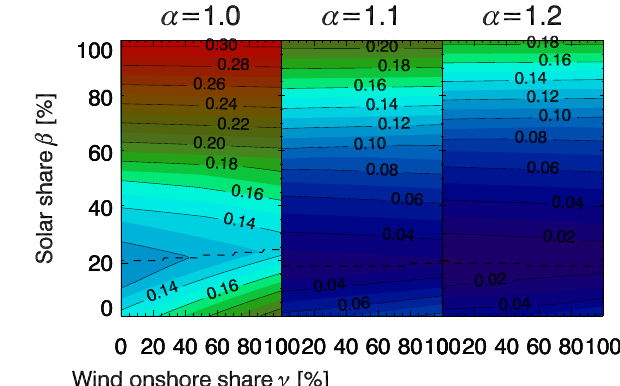
Figure 3. Same as Fig. 2 but for storage capacity needs.